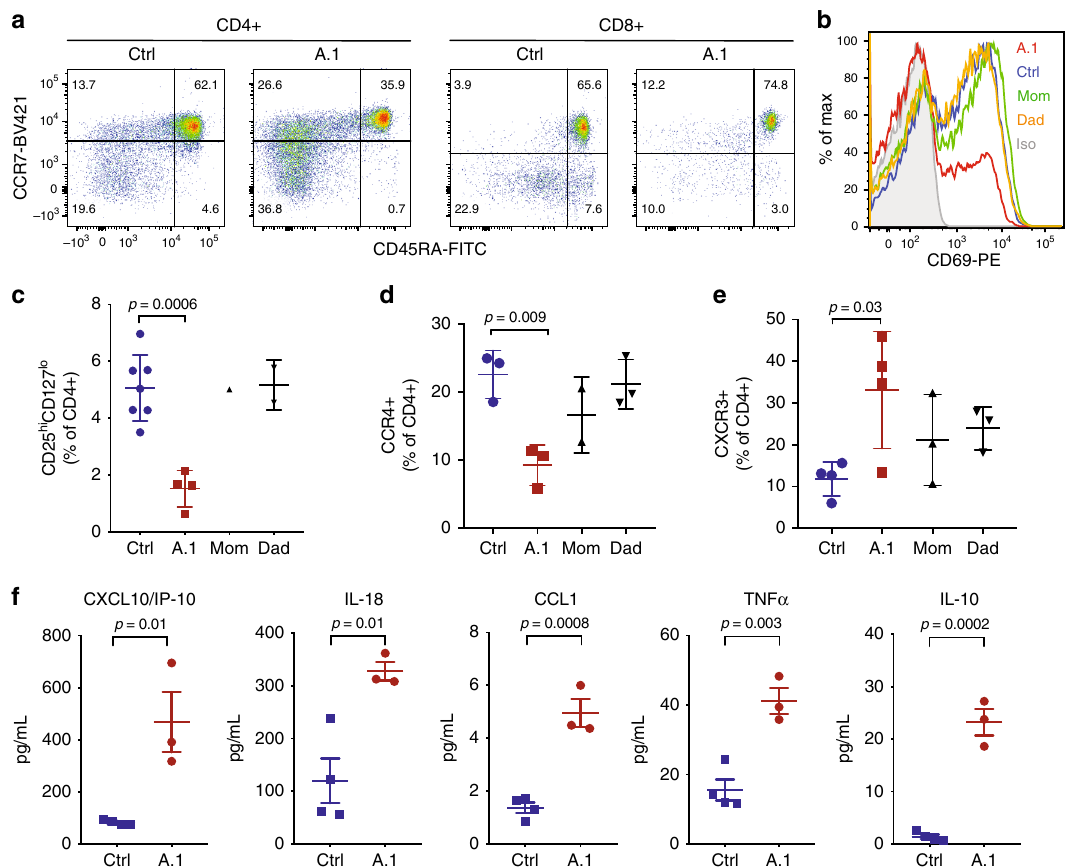
Fig. 2 T cell abnormalities and elevated in fl ammatory serum cytokines/chemokines. a Flow cytometry of T cells from an unrelated healthy control or patient A.1 with staining for CD4, CD8, CD45RA, and CCR7, as indicated. b CD69 expression on CD8 + T cells from peripheral blood of the indicated subjects after 24 h of stimulation in vitro with anti-CD3 and anti-CD28 antibodies. c Frequency of CD25 hi CD127 lo among CD4 + peripheral blood T cells in unrelated healthy controls ( n = 7), patient A.1 ( n = 4), mom ( n = 1), and dad ( n = 2). Data from four independent experiments is presented as mean ± SD. Statistical analysis was performed using one-way ANOVA with Dunnett ’ s multiple comparisons test. d Frequency of CCR4 + among CD4 + peripheral blood T cells in unrelated healthy controls ( n = 3), patient A.1 ( n = 3), mom ( n = 2), and dad ( n = 3). Data from four independent experiments are presented as mean ± SD. Statistical analysis was performed using one-way ANOVA with Dunnett ’ s multiple comparisons test. e Frequency of CXCR3 + among CD4 + peripheral blood T cells in unrelated healthy controls ( n = 4), patient A.1 ( n = 4), mom ( n = 3), and dad ( n = 3). Data from four independent experiments are presented as mean ± SD. Statistical analysis was performed using one-way ANOVA with Dunnett ’ s multiple comparisons